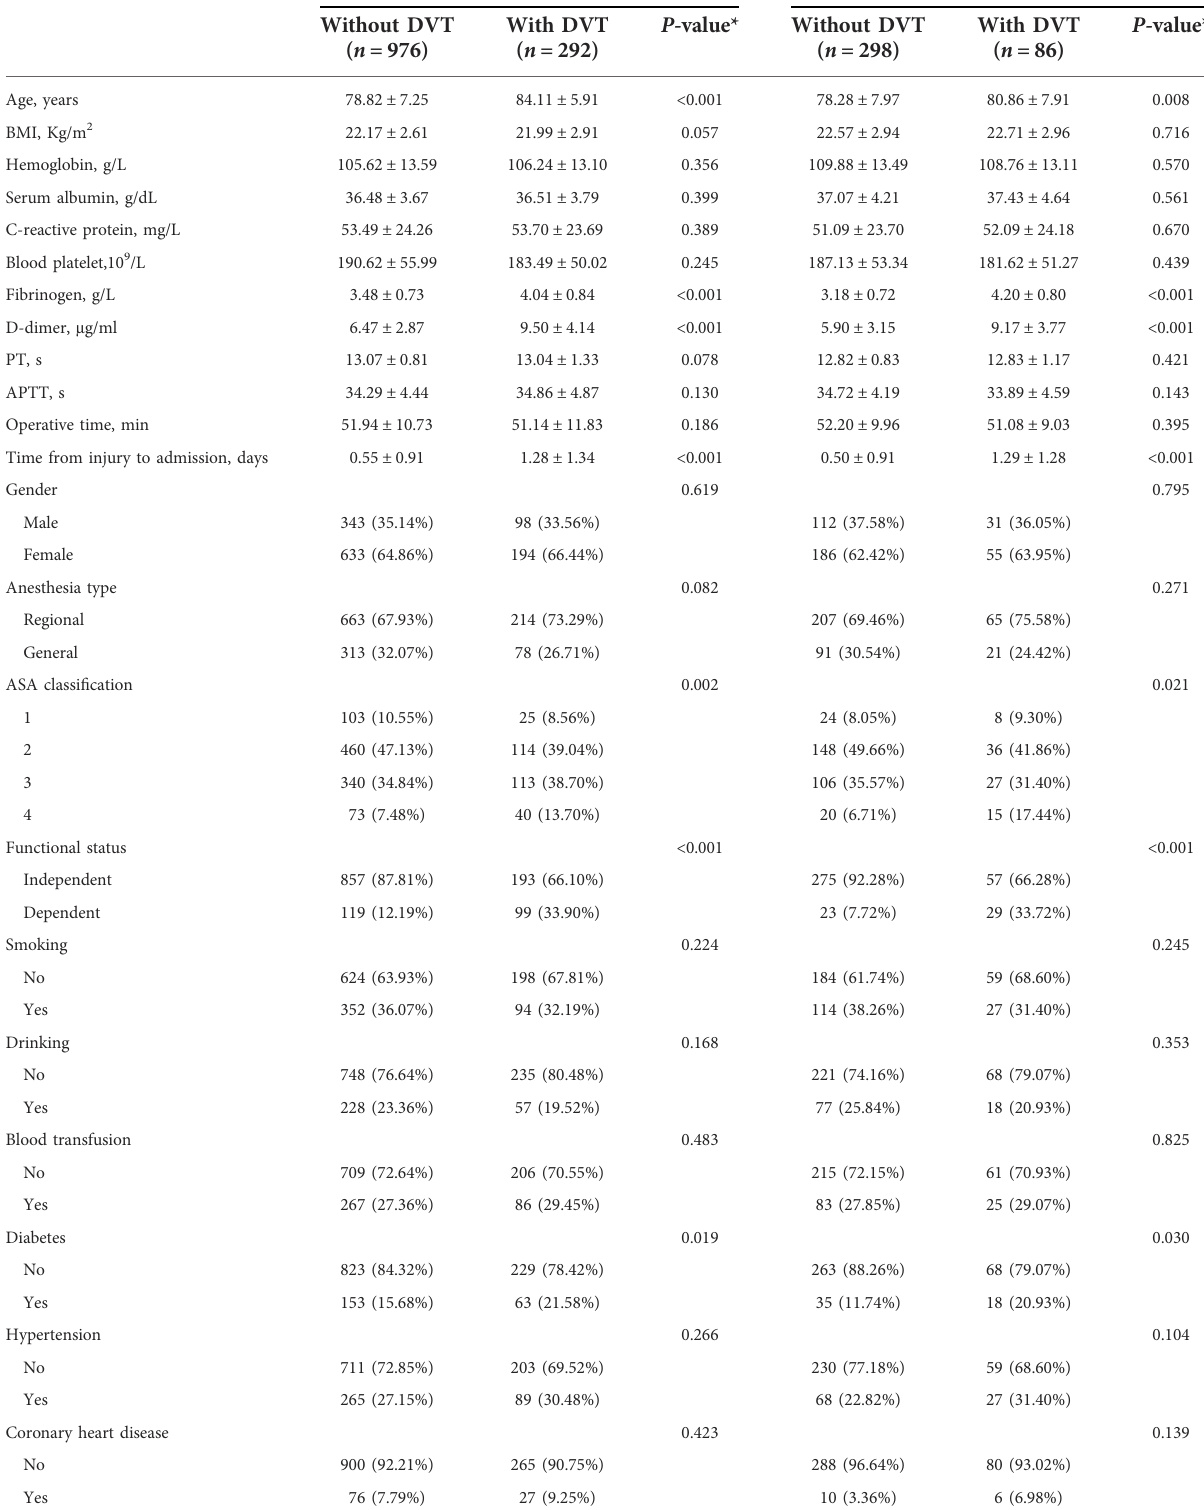
TABLE 1 Baseline